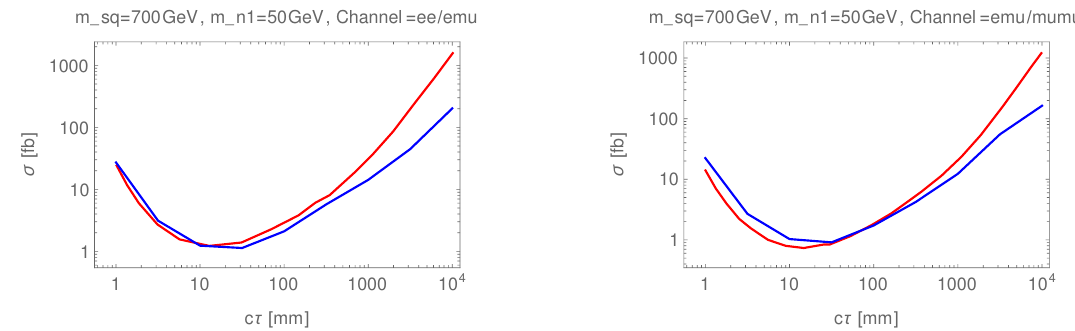
Figure 19. Validation of the displaced lepton vertex search performed by ATLAS by comparing the upper limit on the cross section obtained by ATLAS (red) with the one from our recasting (blue) for the RPV SUSY model studied in